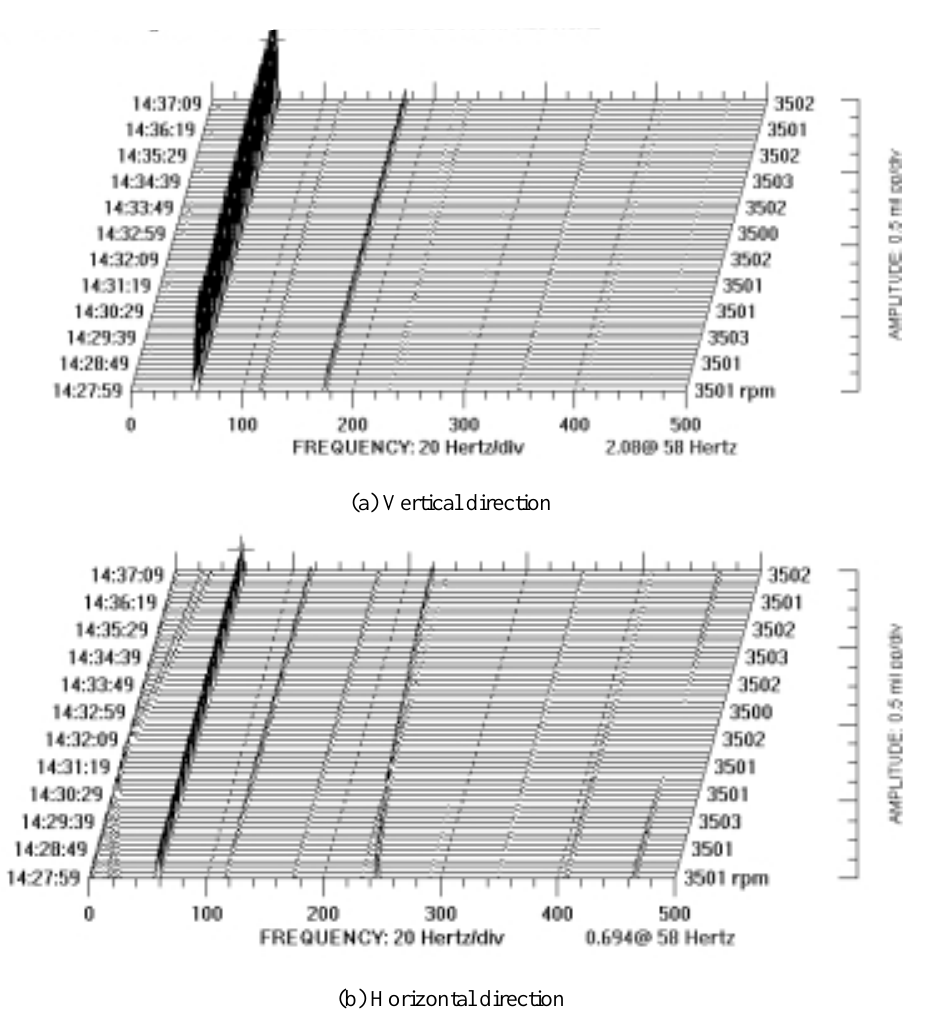
Fig. 4. Frequency waterfalls of steady state data for un-cracked shaft with 8kg hanging side